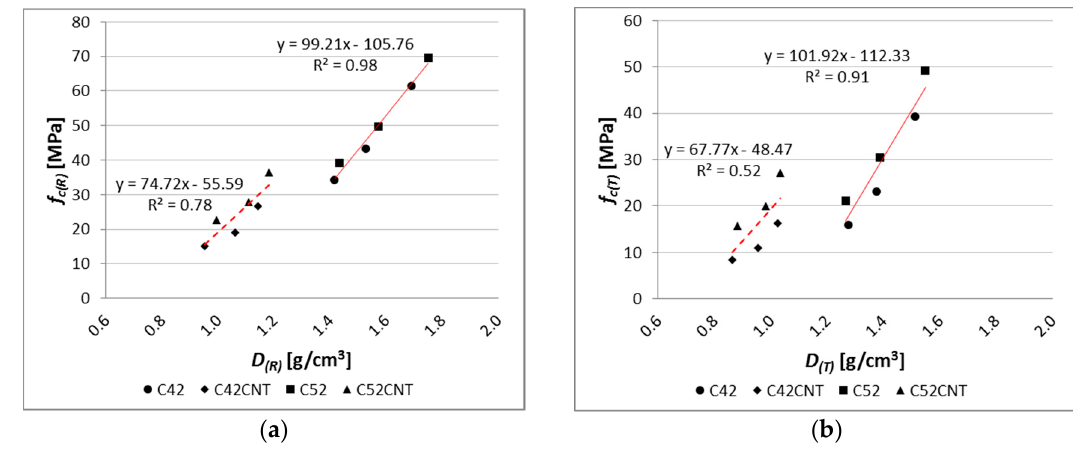
Figure 15. Relationship between compressive strength and apparent density of tested cement pastes for ( a ) reference samples; ( b ) samples after thermal load.